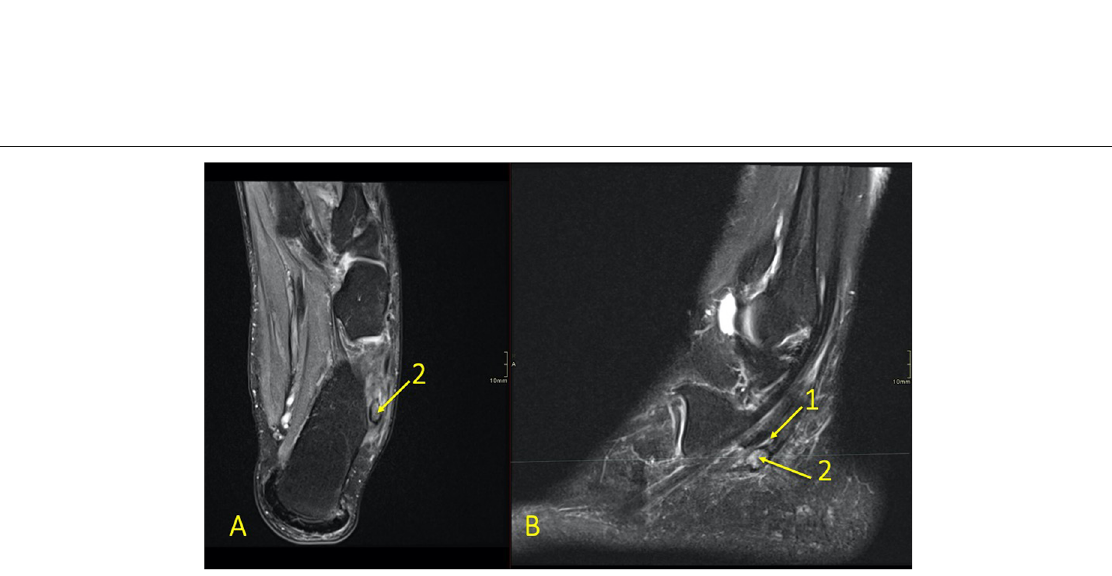
Fig. 22 A 32-year-old handball player presented after a match with lateral ankle pain and a suspected lateral malleolar fracture. (1) MRI revealed a split rupture of the peroneus longus tendon (2) at the level of an os peroneum with BME